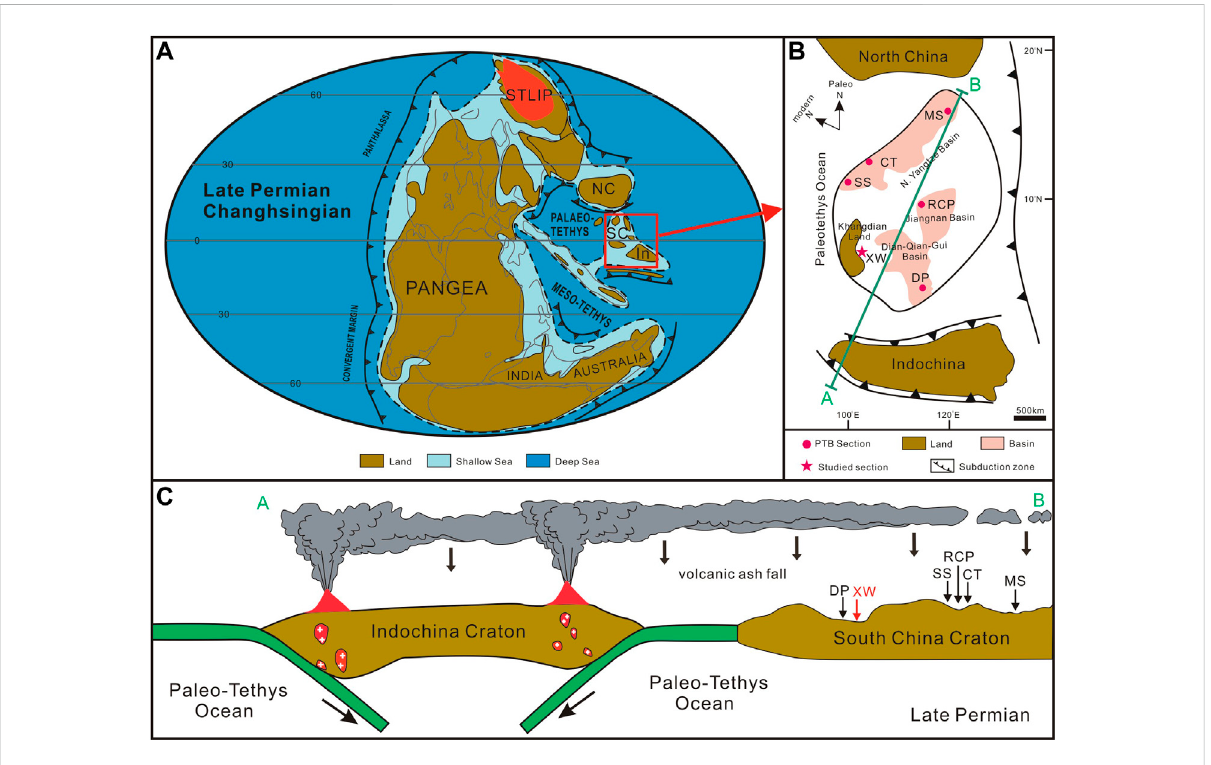
FIGURE 8 (A) Global paleogeography at late permian(Changhsingian) (modi fi ed from Metcalfe,2013; Wang et al., 2019); (B) Potential volcanic ash source areas and inferred direction of ash transport (A → B) in South China and Indochina area during late permian (modi fi ed from Wang et al., et al., 2018; Zhao et al., 2019); (C) Composite cross-section of Late Permian South China and Indochina Craton, showing subduction of the Paleo-Tethys Plate beneath the Indochina Craton margin (modi fi ed from Wang et al., 2018; Zhao et al., 2019). Abbreviations in A: STLIP-Siberian Traps